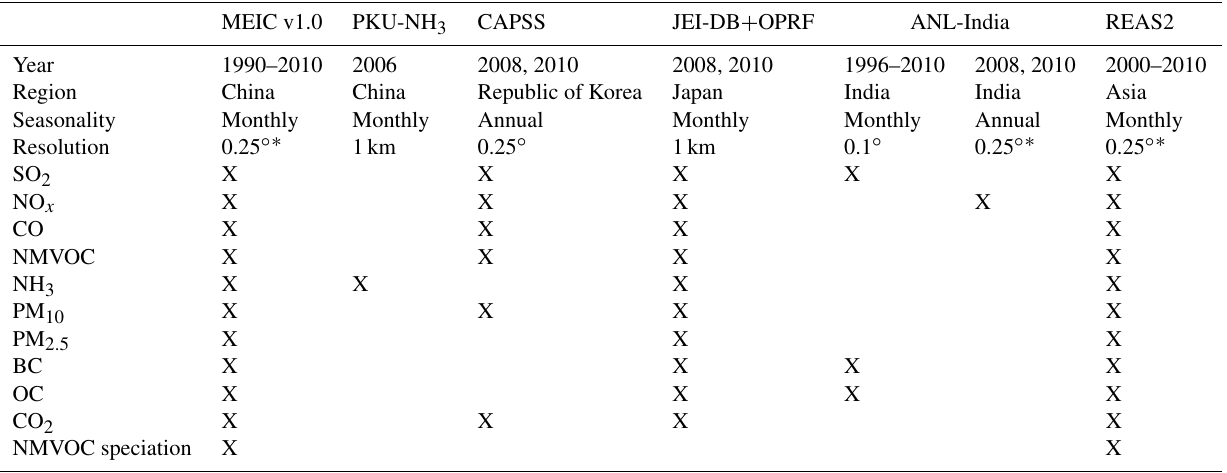
Table 2. List of regional emission inventories used in this work.